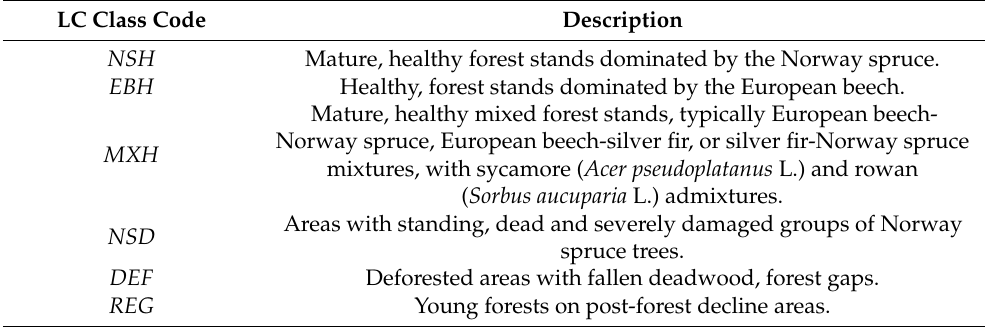
Table 2. LC classes defined in the study with their code and description.